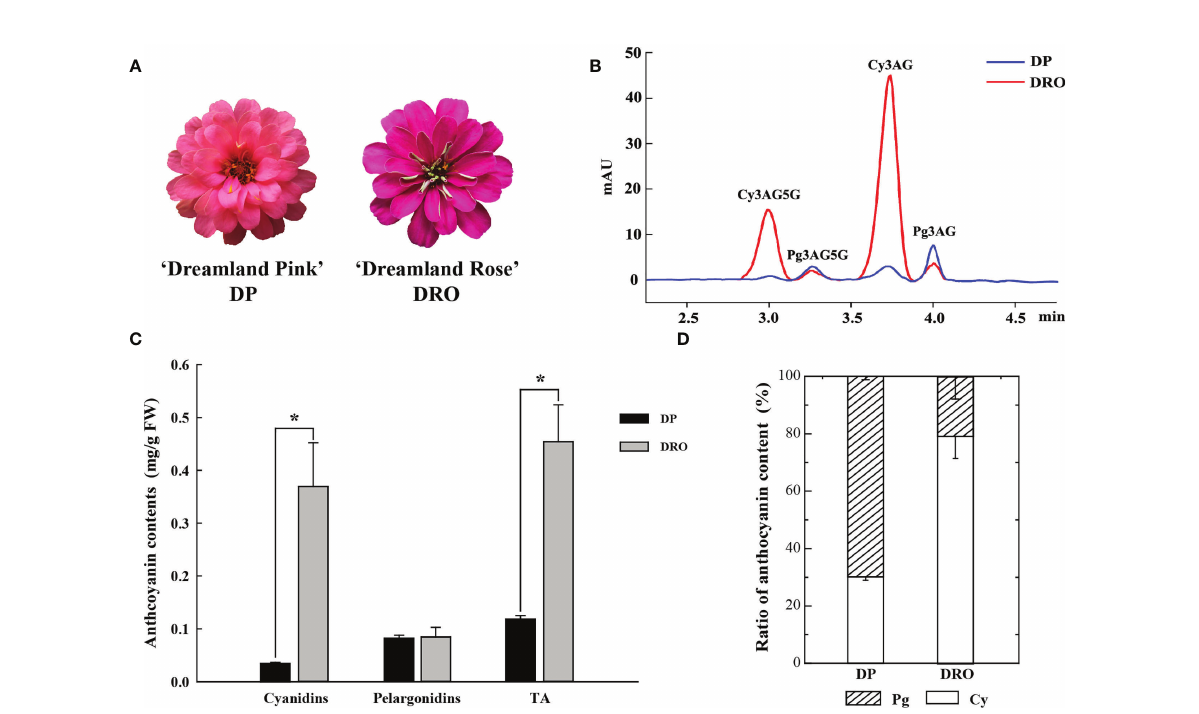
FIGURE 1 The content of anthocyanin components in two cultivars. (A) In fl orescences of Zinnia elegans ‘ Dreamland Pink ’ (DP) and ‘ Dreamland Rose ’ (DRO) at the full opening stage (S4). (B) UPLC chromatogram of DP and DRO at 530nm. (C) The comparison of the content of cyanidins, pelargonidins and total anthocyanin (TA) between DP and DRO. (D) Proportion analysis of the anthocyanin component contents in DP and DRO. Error bars indicated standard error (SE) of three replicates. T-test was used for statistical analyses between two cultivars (* P <